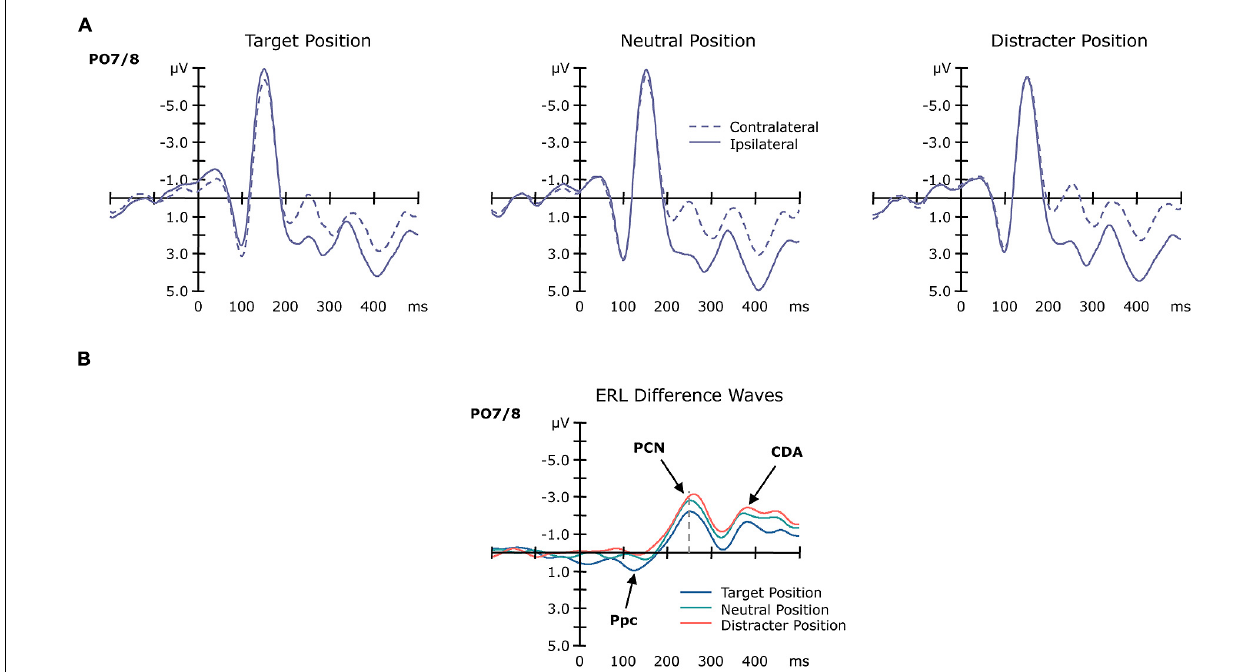
FIGURE 3 | Grand-average ERP waveforms as a function of target position sequence. Panel (A) shows the ERP waves contralateral (dashed line) and ipsilateral (solid line) to the target position at electrodes PO7/8. Panel